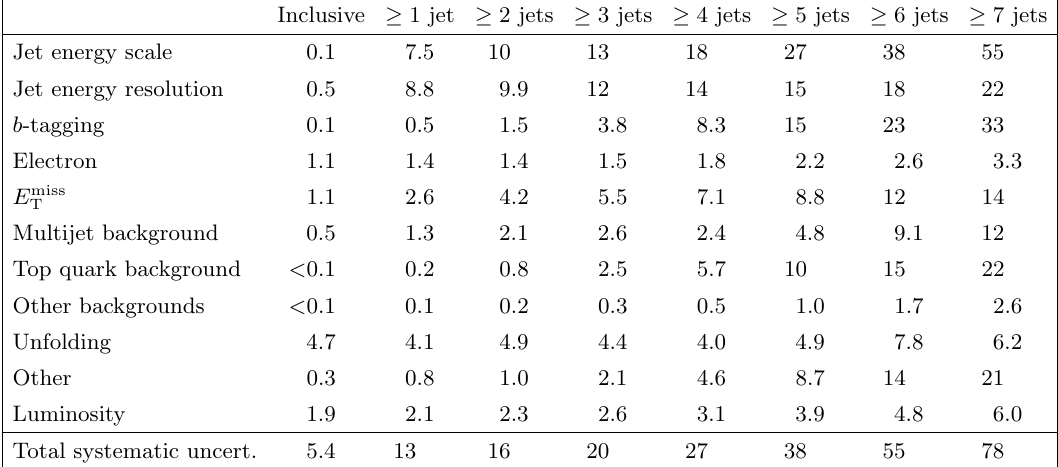
Total systematic uncert. Table 3 . Relative systematic uncertainties in the measured W + jets cross sections in percent as a function of the inclusive jet multiplicity. The uncertainty from b -tagging includes the uncertainties in the b -tagged jet identi(cid:12)cation and misidenti(cid:12)cation e(cid:14)ciencies as well as the impact of W + c; c (cid:22) c; b (cid:22) b cross sections in the extrapolation from the signal region to the (cid:12)ducial region. Other backgrounds summarises the impact of Z and diboson cross sections as well as the statistical uncertainty in the background estimates. Other combines uncertainties in the pileup modelling and the impact of matching jets to the primary vertex. The luminosity uncertainty includes a global uncertainty of 1.9%, in addition to the components discussed in the paper [1].